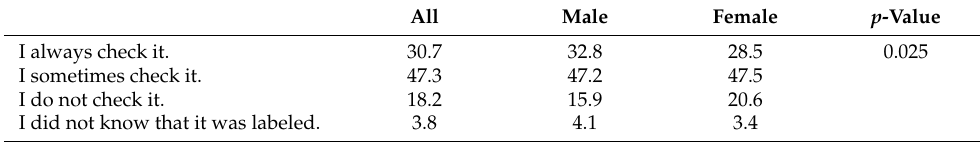
Table 13. Confirmation of labeling of mineral contents on fortified food/supplements. All Male Female p -Value